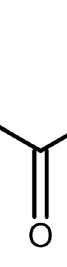
Figure 1. Structure of the oxalate ion.